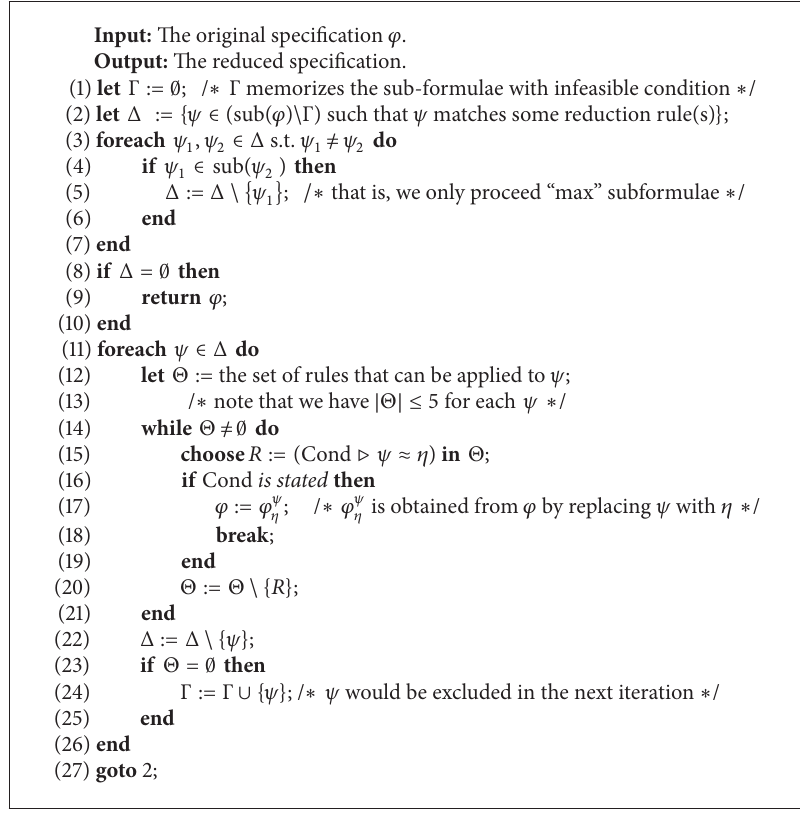
Algorithm 1: The “max-match” rule-selection